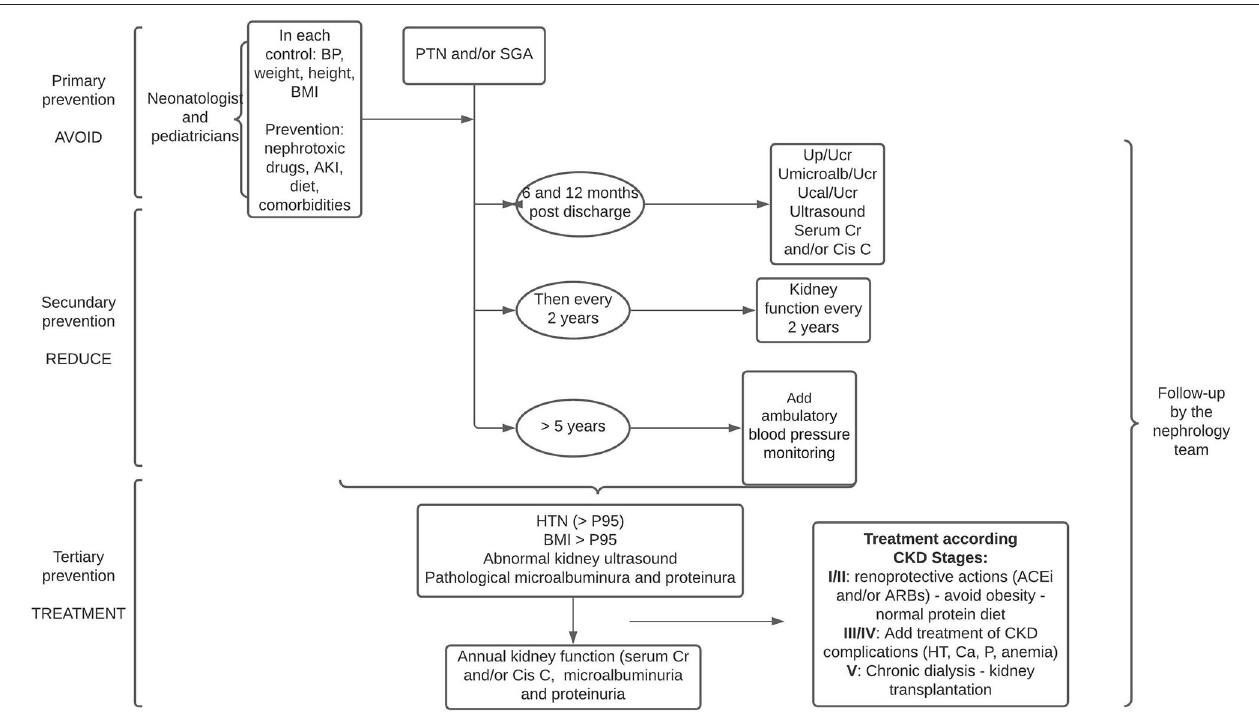
FIGURE 3 | Follow-up proposal for PTN and/or SGA infants in three stages: avoid, reduce, and treat. Cr, creatinine; Cis C, cistatine C; Up/Ucr, urine protein or urine creatinine; UMicroalb/Ucr, urine microalbuminuria or urine creatinine; Ucal/Ucr, urine calcium or urine creatinine; BP, blood pressure; ACEi, angiotensin-converting enzyme inhibitors; ARBs, angiotensin II receptor